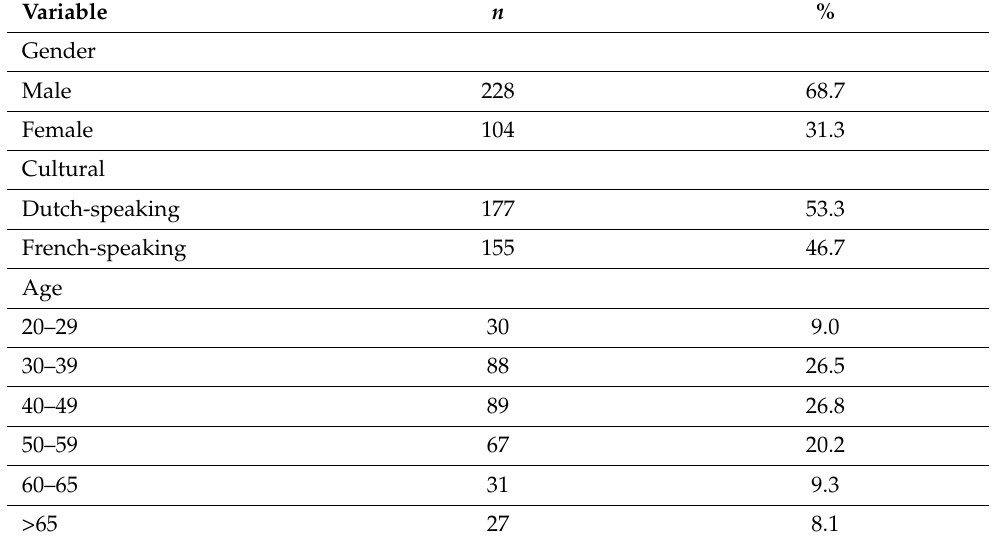
Table 1. Distribution by gender, culture and age ( n = 332).